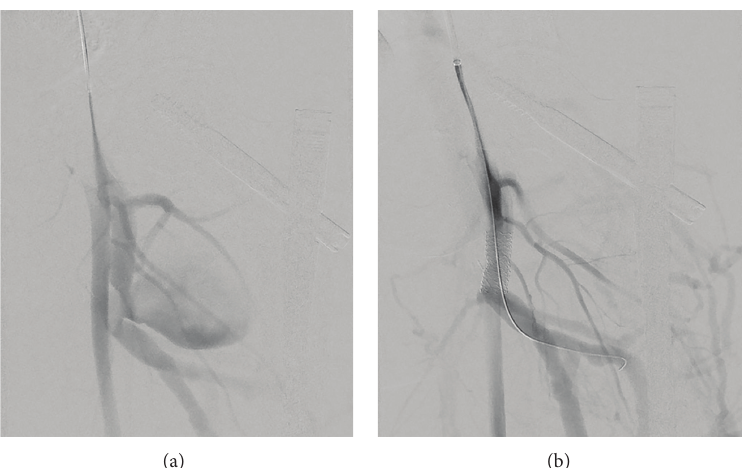
Figure 3: Angiogram of left lower extremity showing (a) the left profunda femoris pseudoaneurysm and (b) the poststent placement angiogram showing resolution of the